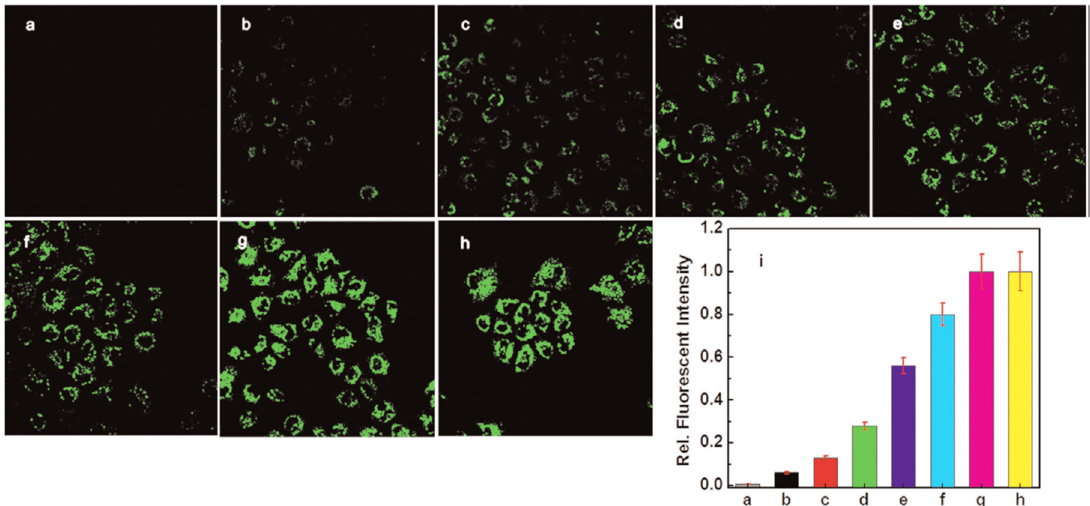
Figure 3. Fluorescence confocal microscopic images of living HL-7701 cells incubated with various concentrations of Fe 3+ : ( a ) Cells loaded with 50 μ M of iron chelator desferoxamine (DFO) for 40 min. ( b ) Cells loaded with 10 μ M 43 for 10 min as control. ( c )–( h ) Cells incubated with 0.01, 0.1, 1, 10, 100, and 1000 μ M Fe 3+ , respectively. ( i ) Quantification of mean fluorescence intensity of the images a–h (scale bar is 20 μ m) (Reproduced from Ref. [50] with permission from Elsevier).